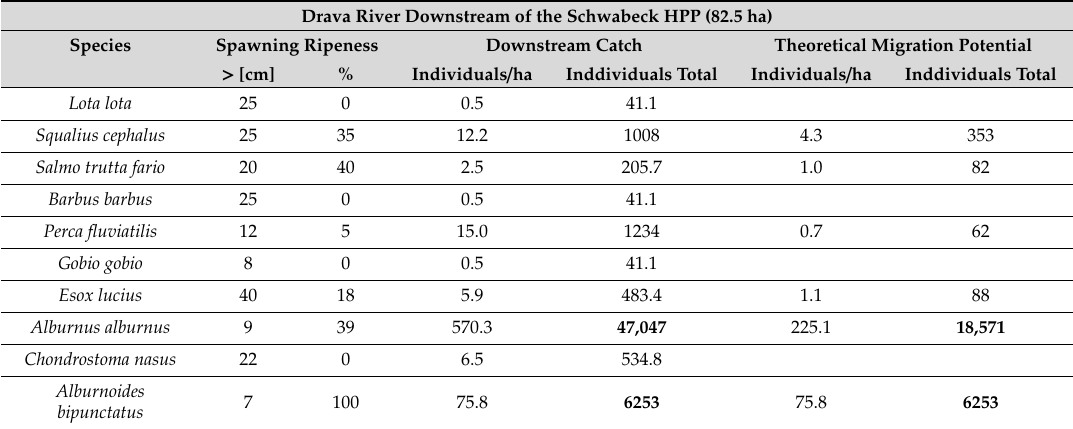
Table 2. Theoretical migration potential downstream from the fish